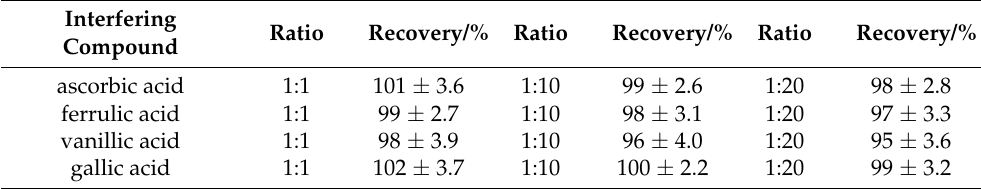
Table 5. Interference of chemically related compounds with the quantitative determination of PCA 10 − 5 M. Interfering Ratio Ratio compound